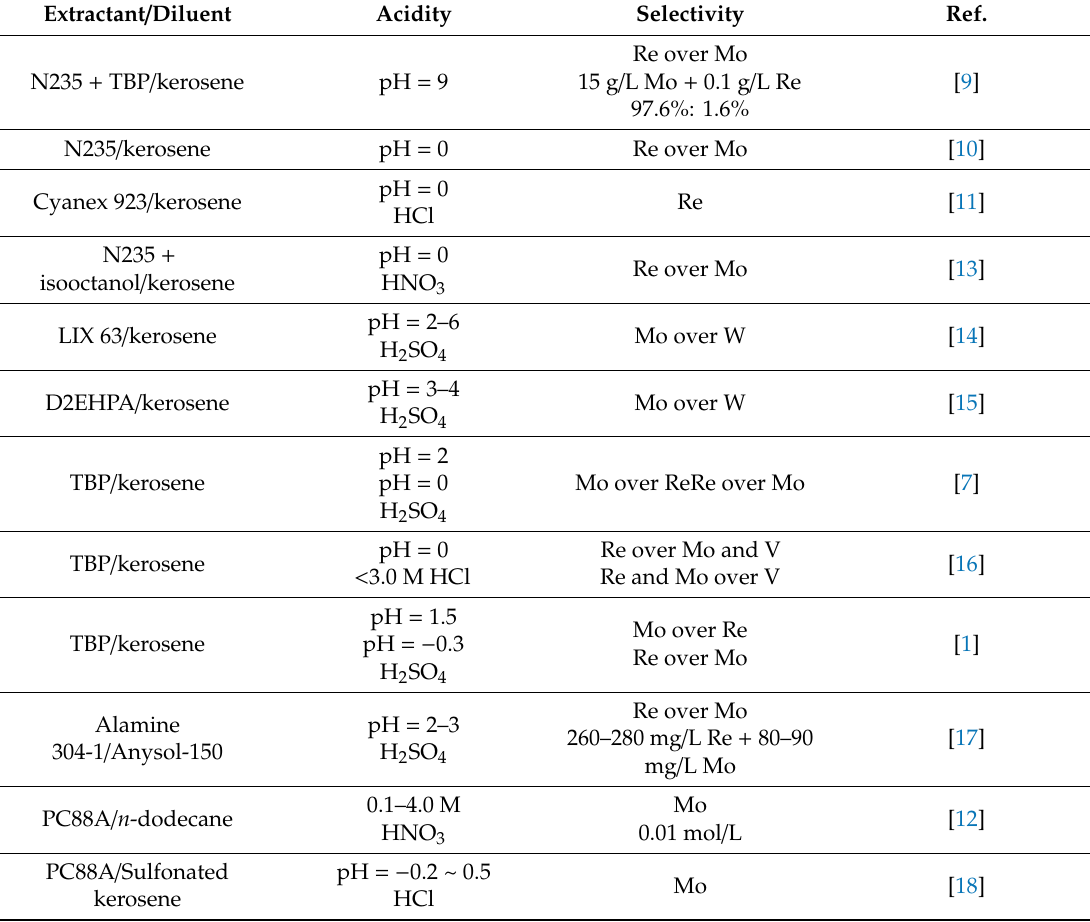
Table 1. Literature on Mo and Re solvent extraction.